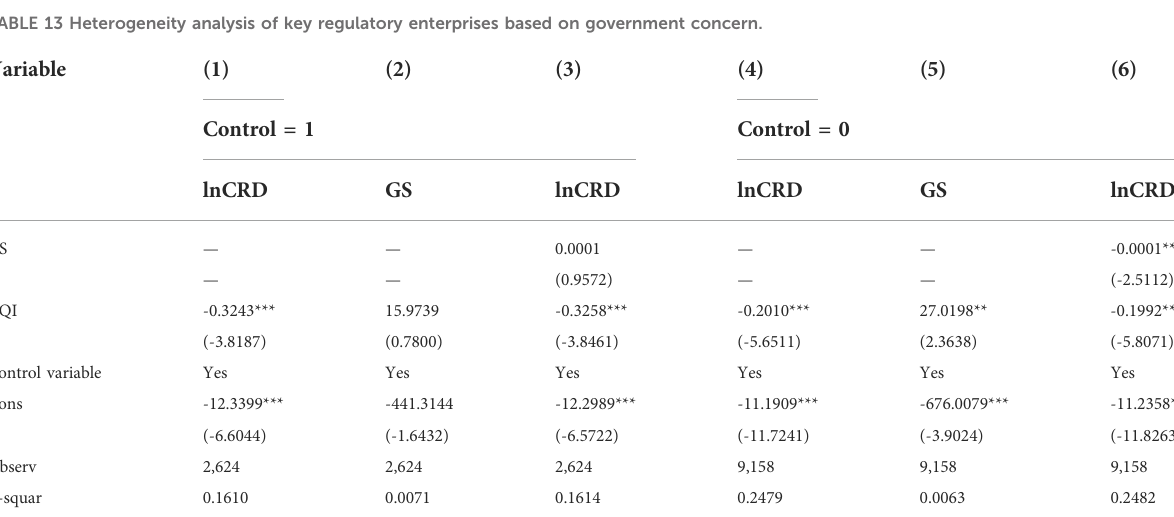
Control variable Cons